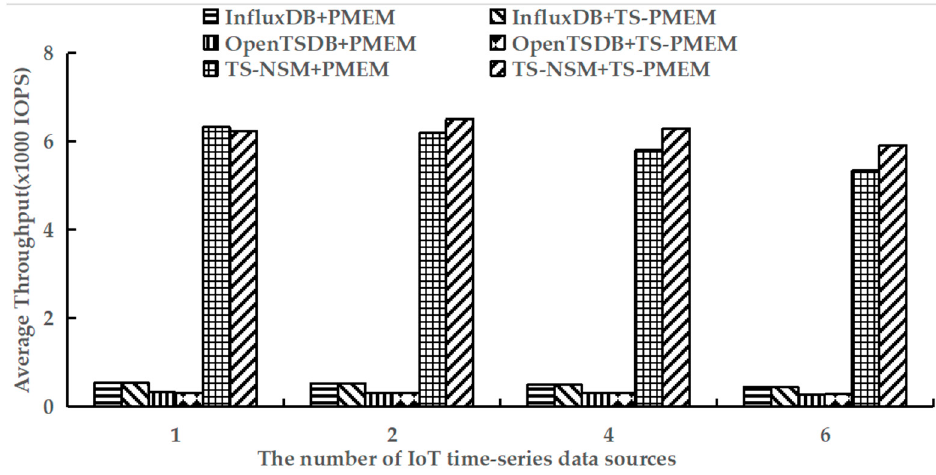
Figure 9. Average range query throughput under testworkloadb.